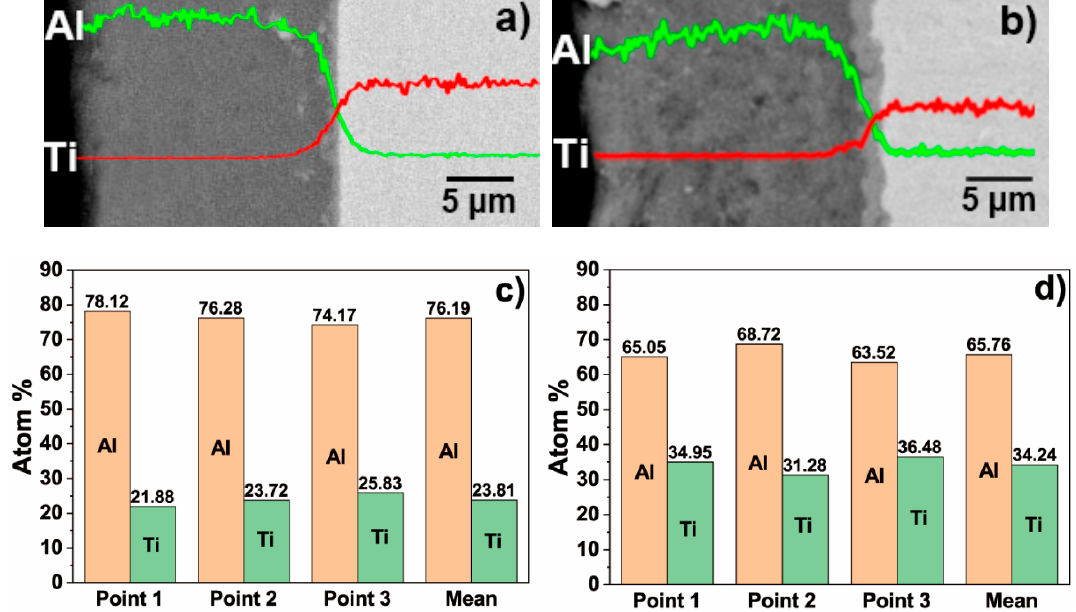
Figure 4. EDS element mapping of aluminium and titanium of ( a ) the T ‐ 1 and ( b ) T ‐ 2 samples; ( c ) and ( d ) the EDS point ‐ scan analysis of hot ‐ dip aluminised coatings formed on TA2 substrates for corresponding points in Figure 3b,d).